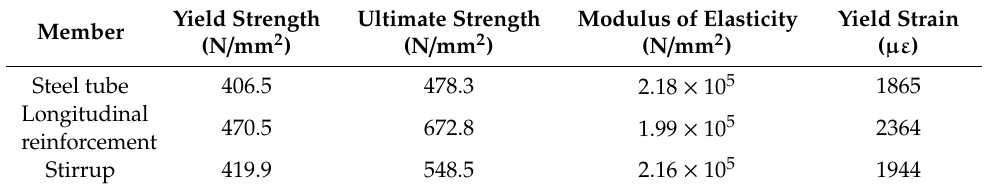
Table 4. The measured mechanical properties of steel.